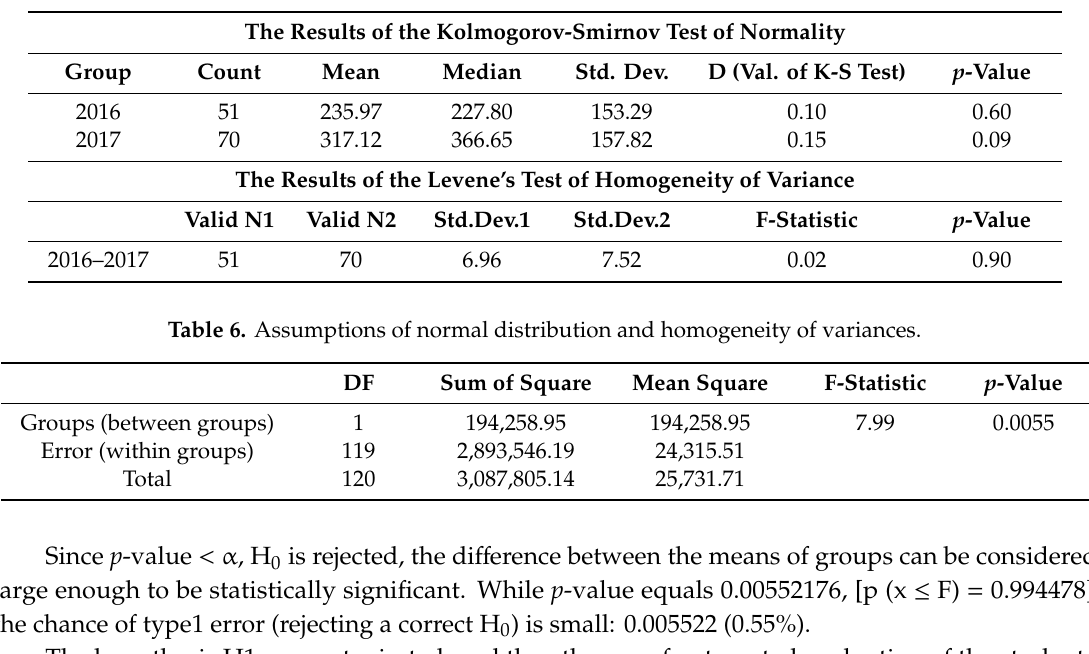
Table 5. Assumptions of normal distribution and homogeneity of variances.